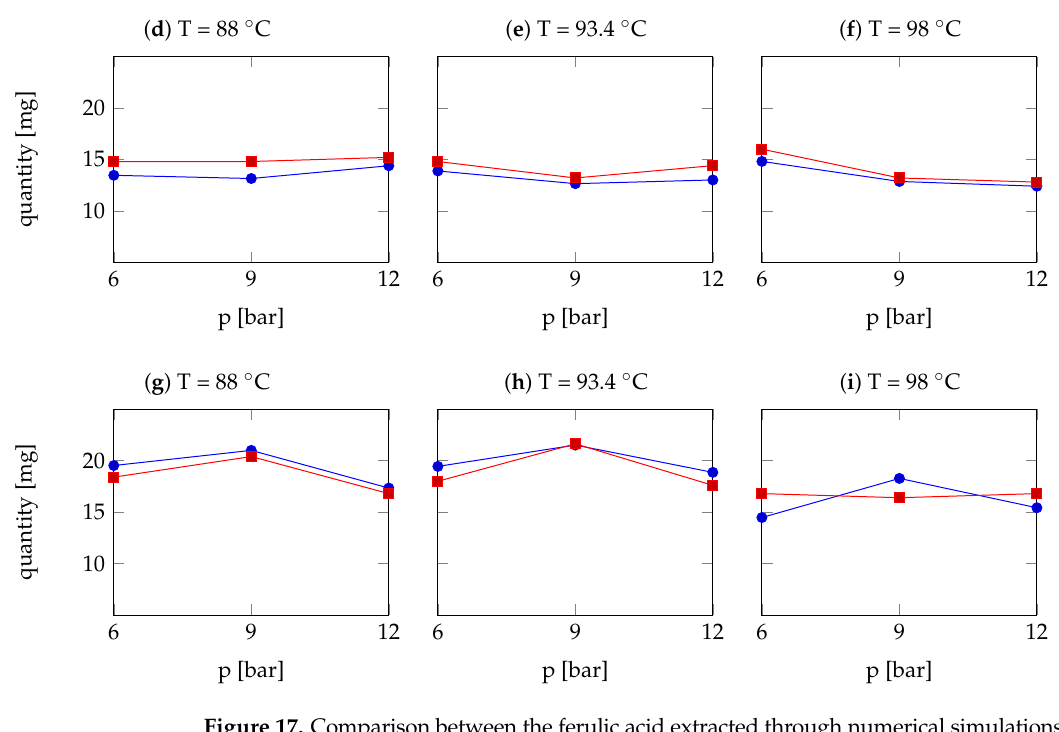
Figure 17. Comparison between the ferulic acid extracted through numerical simulations (blue profile with circles) and laboratory measurements (red profile with squares), with different inlet water tempera- tures and pressures and different grain size of Robusta coffee powder. Figures ( a – c ) show the results of optimal granulometry, Figures ( d – f ) of coarse granulometry and Figures ( g – i ) of fine granulometry.